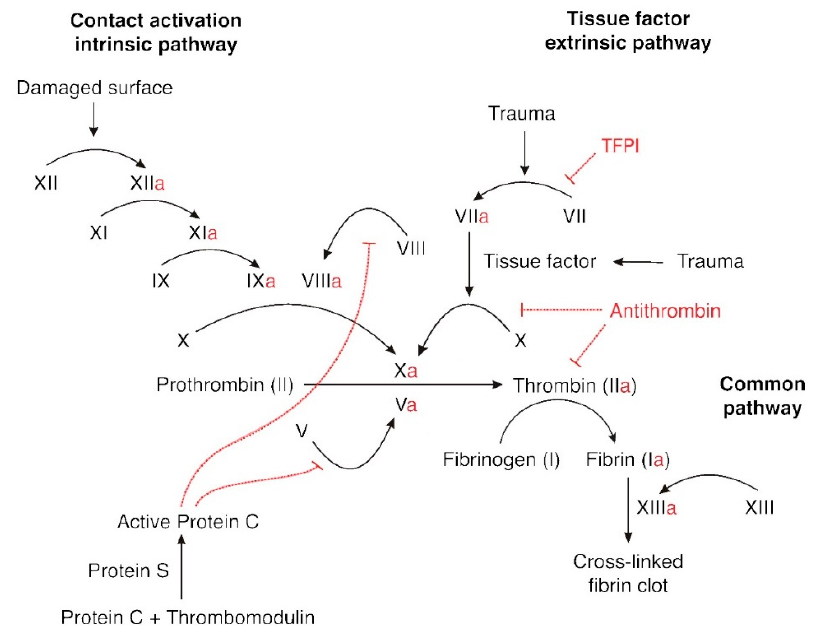
Figure 1. The figure shows a scheme of a coagulation cascade. Drugs used in antithrombotic therapy work at different stages of the clotting process (Table 1). Table 1. Antithrombotic drugs